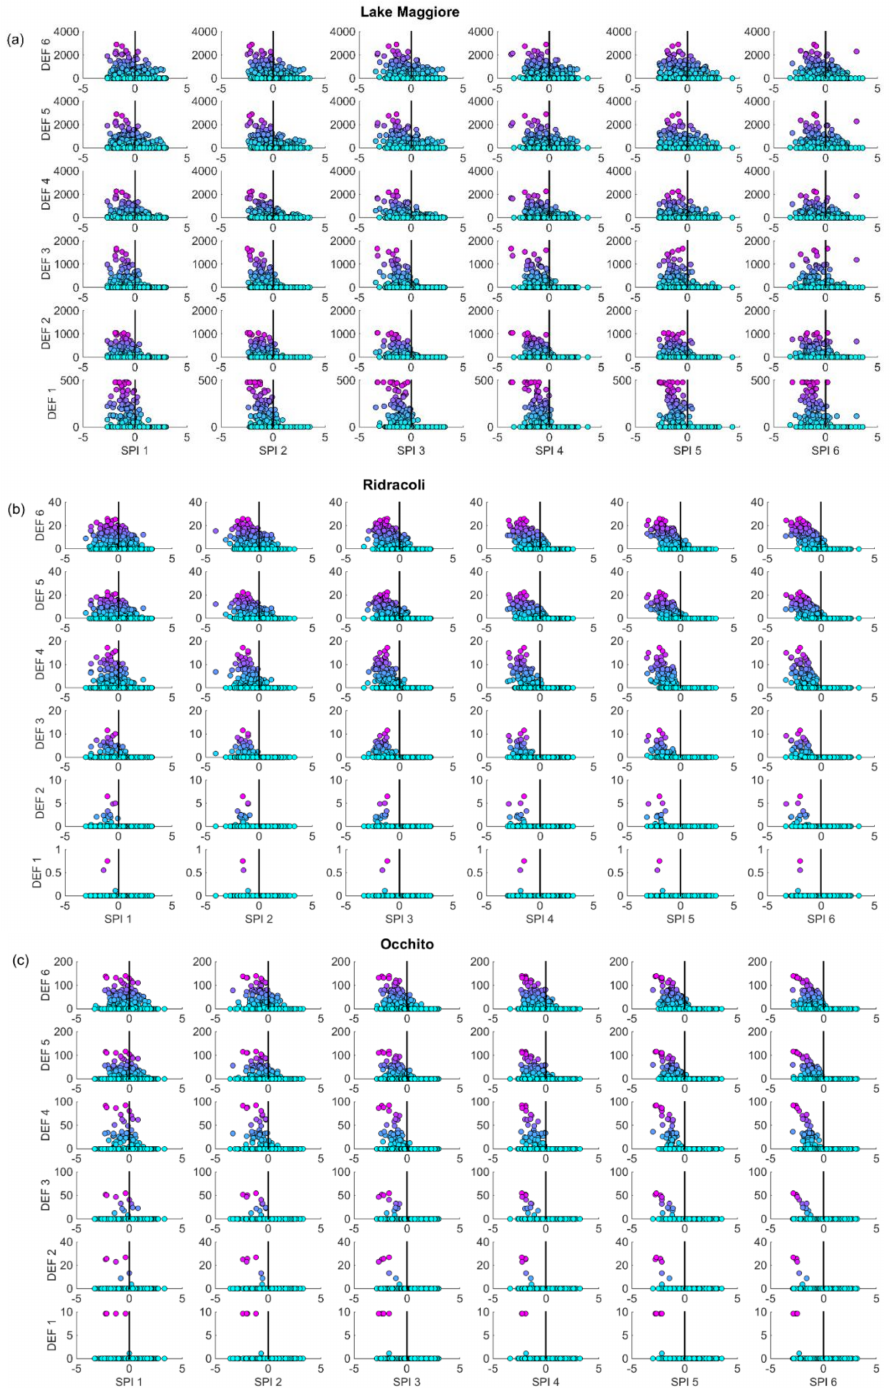
Figure 9. Results of the SUPPORT TO EARLY-WARNING module (overview). ( a ) Lake Maggiore. ( b ) Ridracoli. ( c ) Occhito. Colorcode refers to the cumulated